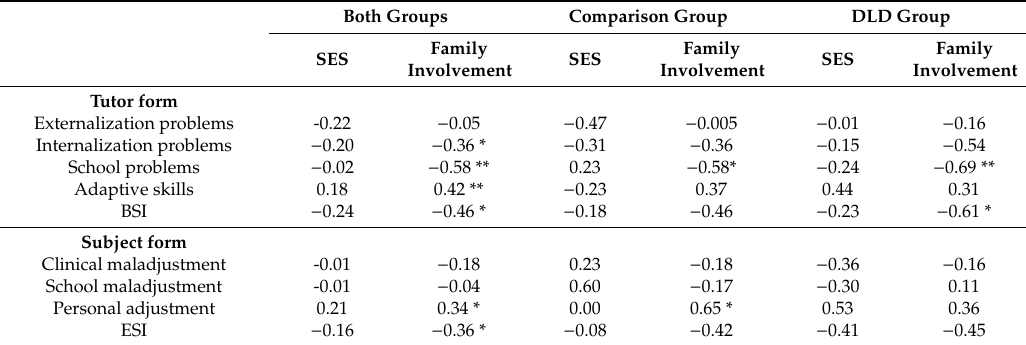
Table 2. Spearman correlation coe ffi cients ( (cid:37) ) between socioeconomic status (SES), family involvement and the variables of the